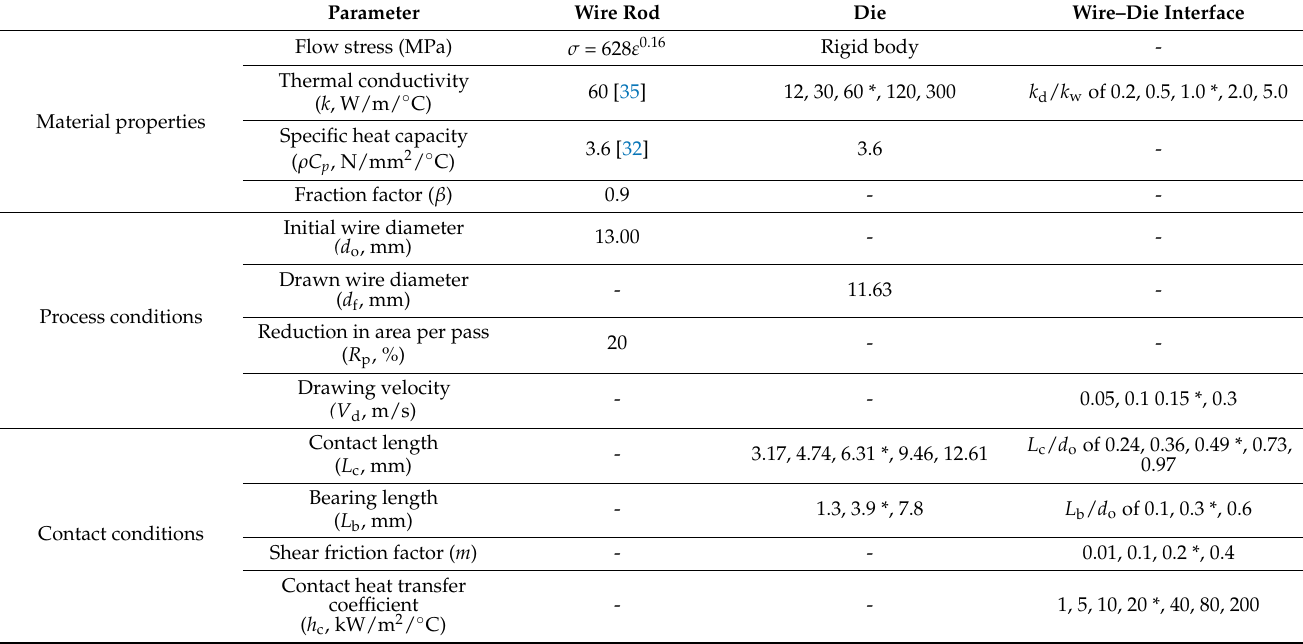
Table 1. Material properties and process conditions of specimen and die used in FEA. * indicates the standard operating condition.